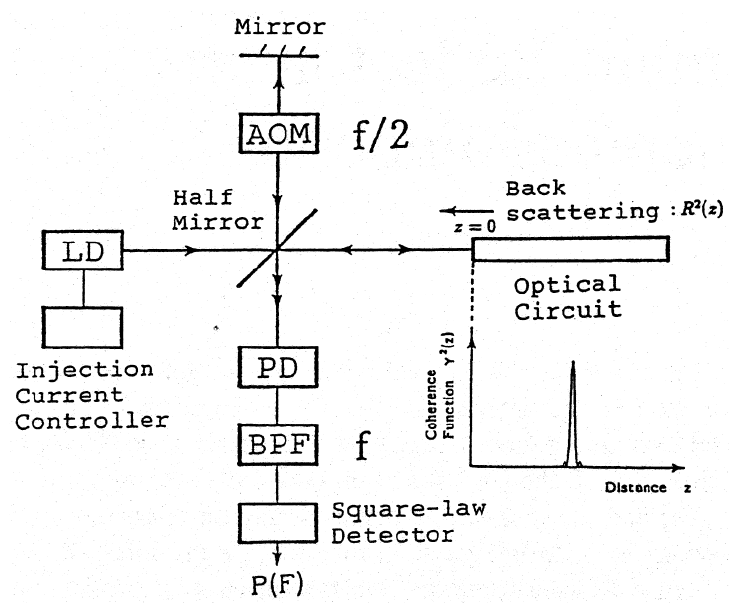
Figure 3. Optical system for distributed sensing with synthesis of optical coherence function [16].